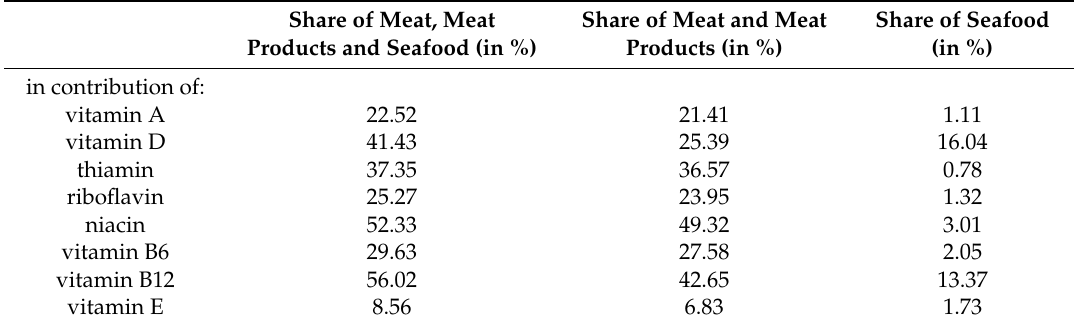
Table 7. The share of meat, meat products and seafood in contribution of vitamin A, vitamin D, thiamin, riboflavin, niacin, vitamin B6, vitamin B12 and vitamin E in the average Polish diet.